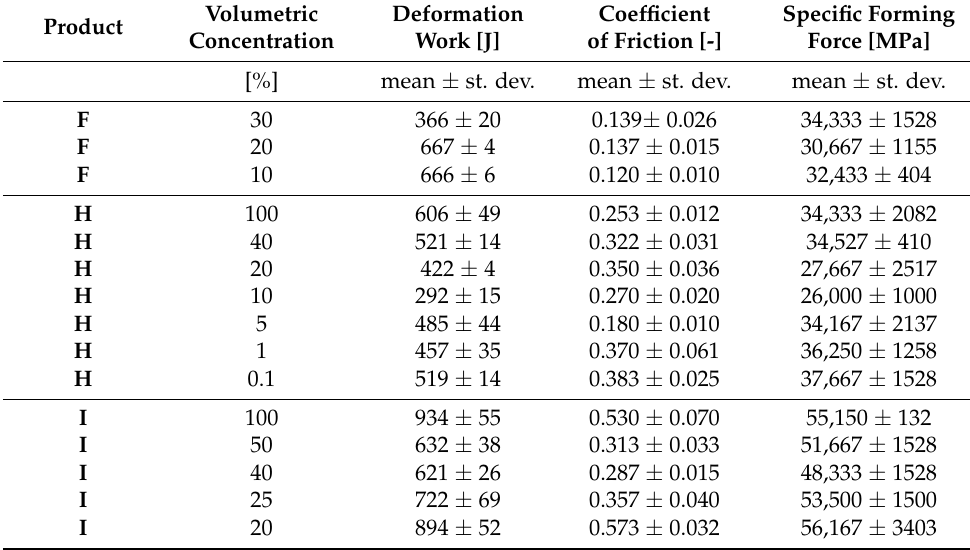
Table 6. An overview of the measured parameters for the tested polymer F , H , and I